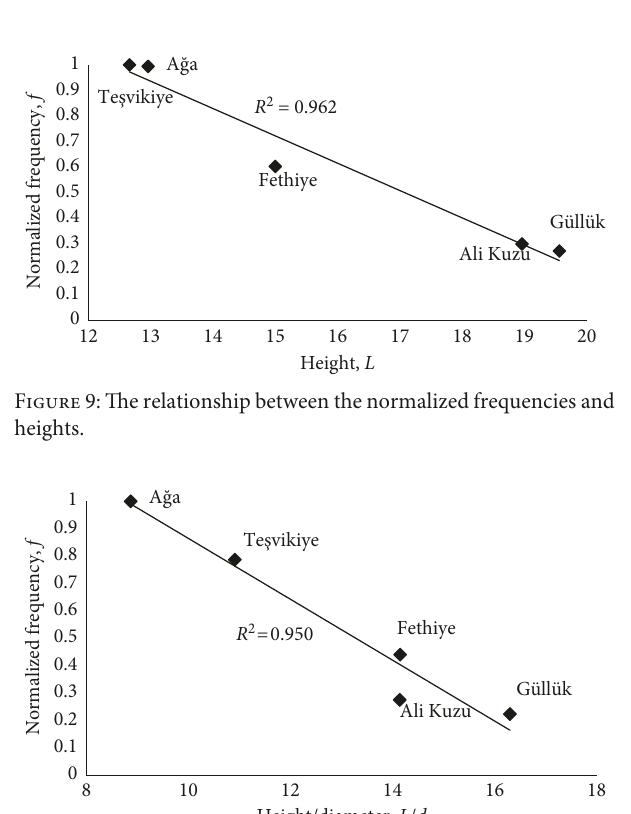
Figure 8: The relationship between the stiffness-to-mass ratios and frequencies.